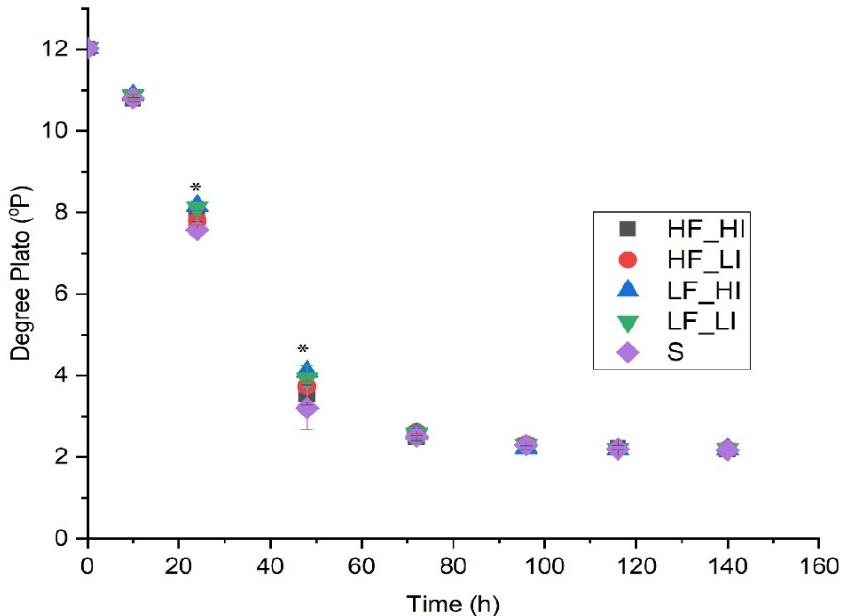
Figure 2. Wort gravity during fermentation over time for five sound treatments. Low-frequency and low-intensity (LF_LI); low-frequency and high-intensity (LF_HI); high-frequency and low-intensity (HF_LI); high-frequency and high-intensity (HF_HI); silence (S). * Significant differences observed at 24 and 48 h (Table S2 Supplementary Material). Data shown are the means of three fermentation replicates ± standard deviation.